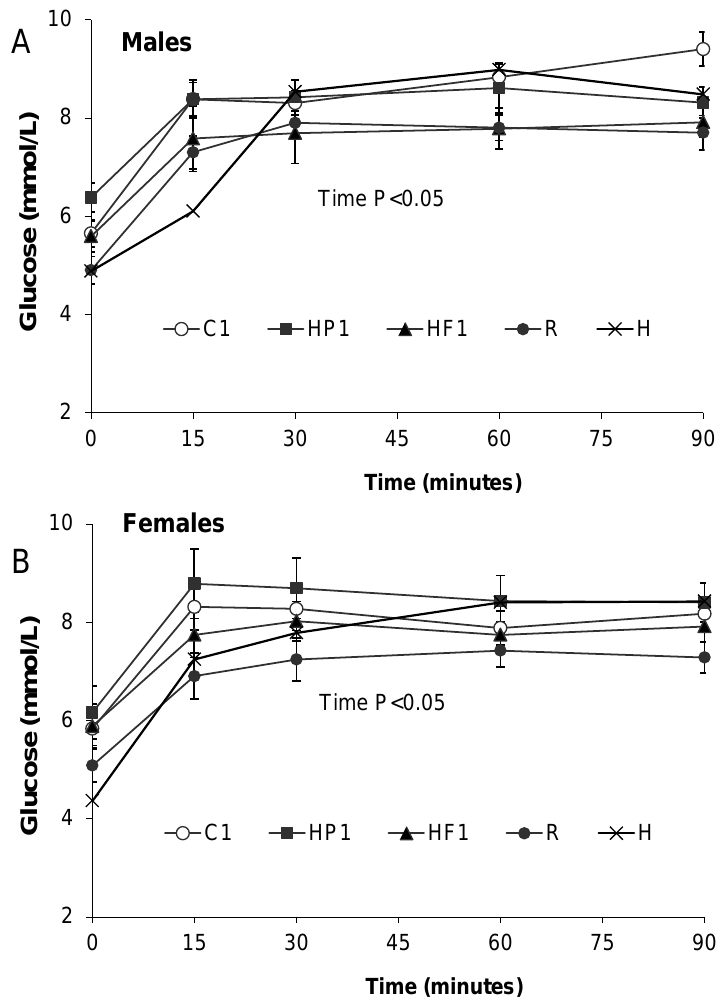
Figure 6. Blood glucose concentrations during an oral glucose tolerance test in male ( A ) and female ( B )